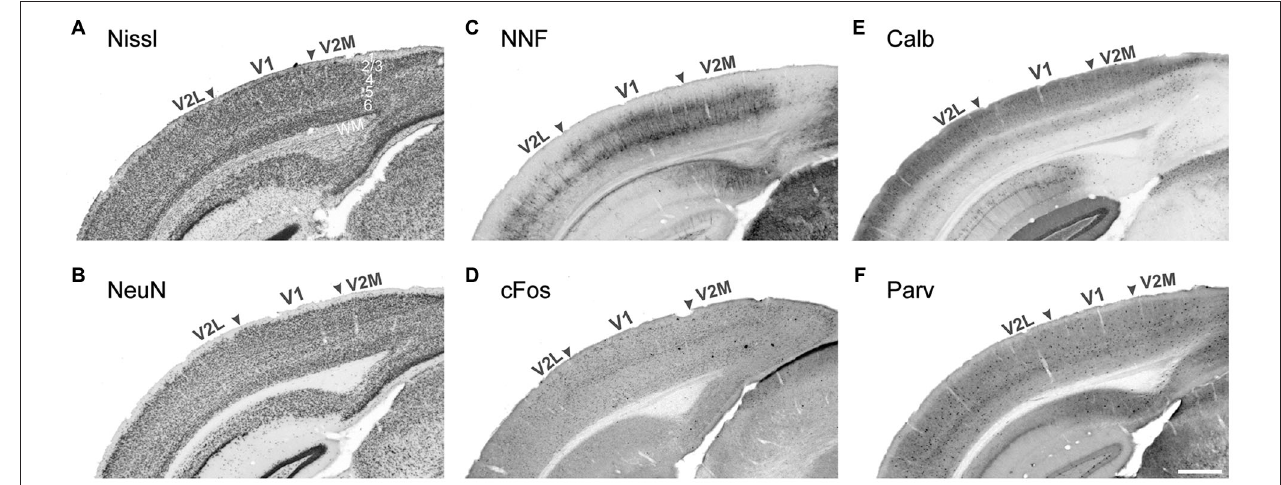
medial secondary visual areas (V2L and V2M respectively). The interneuronal markers Calbindin (E) and Parvalbumin (F) display strong laminar differences with a higher density of Calbindin+ cells in layers 2–4. Stronger Calbindin signal in V1 layer 4 is very efficient at demarcating the borders with adjacent secondary areas. WM white matter Scale bar in (F) 500 µ